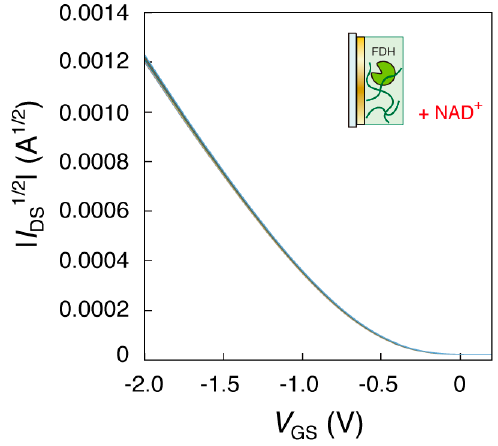
Figure 3. Transfer characteristic curves of the OFET-based sensor with a gold electrode coating FDH/CT gel, scanned 13 times for 1 h in 10 mM phosphate buffer (pH 7.4) including 1 mM of [NAD + ] at 25 °C.